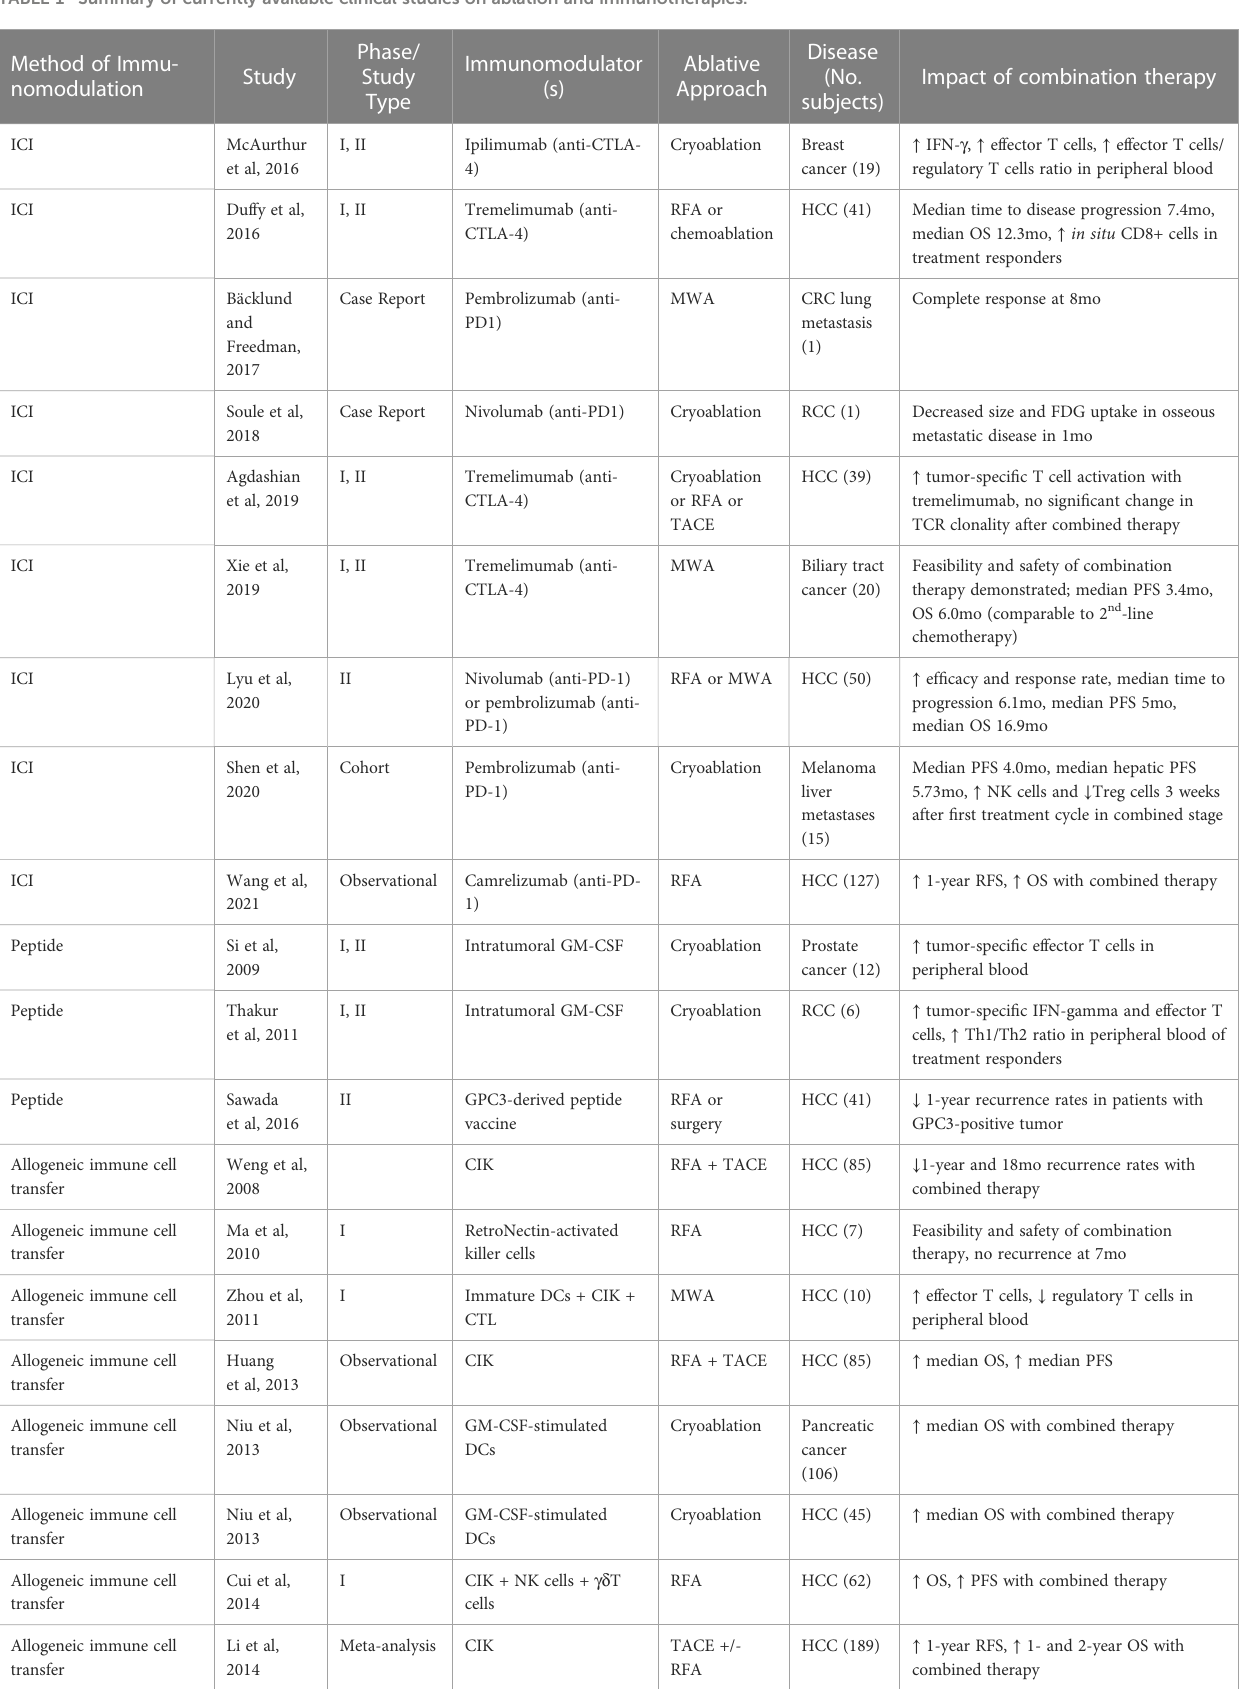
TABLE 1 Summary of currently available clinical studies on ablation and